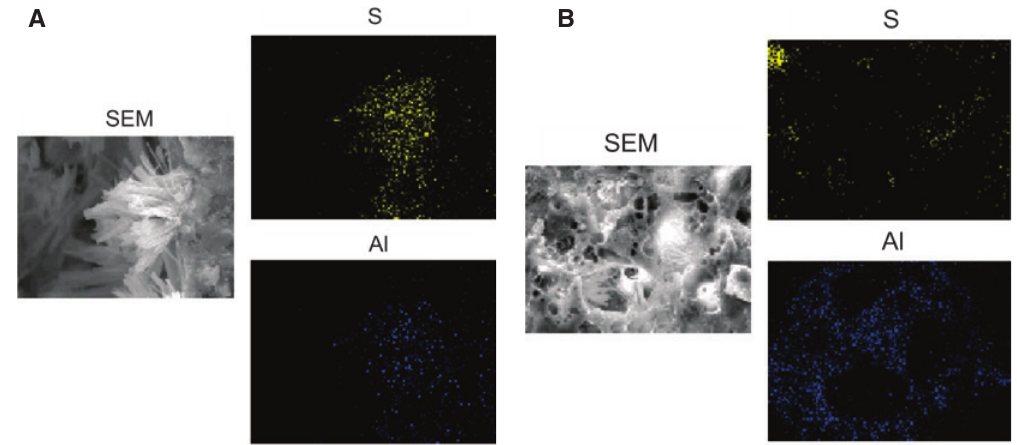
Figure 9 XRM analysis of ettringite crystal in the air bubble of AEA: (A) specimen BI-DT; (B) specimen